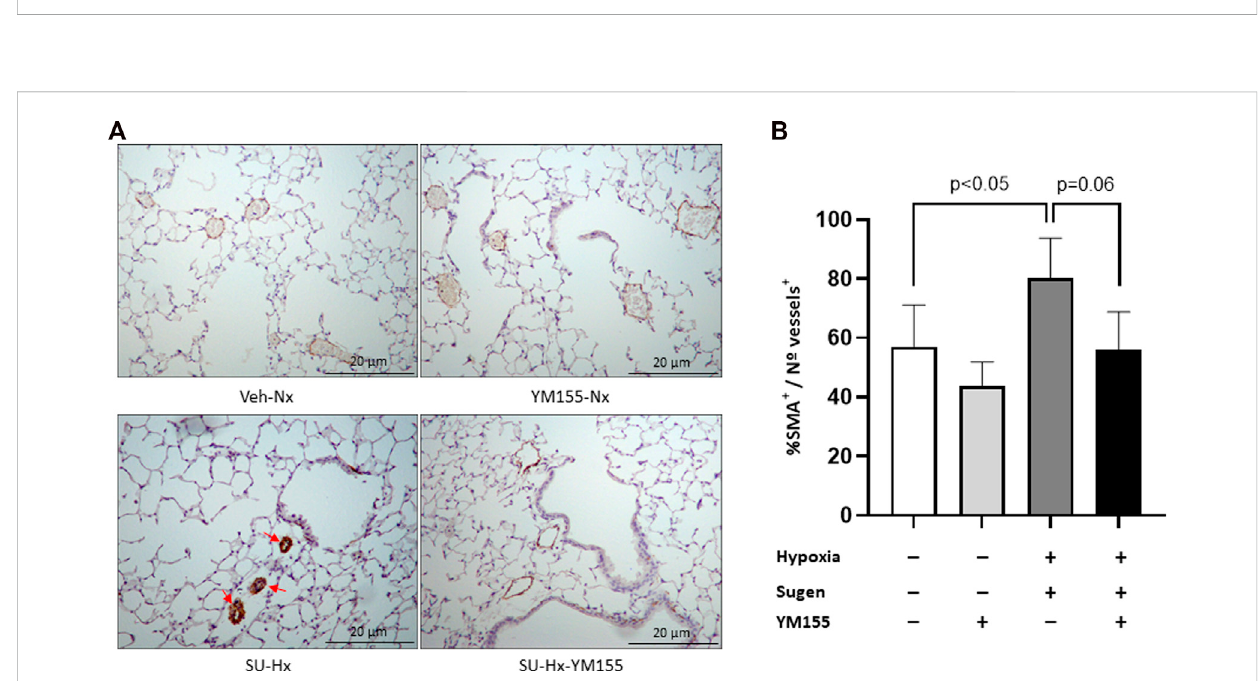
FIGURE 2 EffectofYM155onrightventriclesystolicpressureandhypertrophyinSU5416/hypoxia-inducedPAHmice.Valuesofrightventriclesystolicpressure (RVSP) (A) and right ventricular hypertrophy as measured by the Fulton ’ s index (B) in the different study groups. Values are expressed as mean ± SD. Statistical signi fi cance was assessed by the one-way ANOVA. Drugs doses used were: SU5416, 20 mg/kg, s. c.i; YM155, 5 mg/kg, s. c.i.